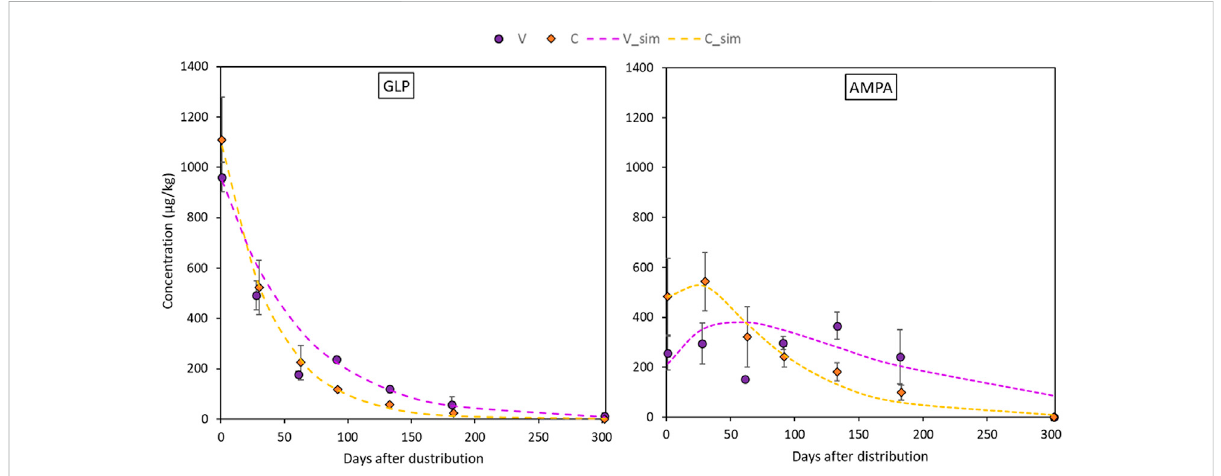
FIGURE 4 Dissipation dynamics of GLP in the topsoil layer (0 – 5 cm) for the the two sites fi tted with the SFO equation (on the left, Eq. 2) and formation/ dissipation dynamics of AMPA in the topsoil layer for the two sites fi tted in Eq. 3 (on the right). Dots refer to experimental concentrations (orange for Conegliano and purple for Valdobbiadene) and lines refer to fi tted dynamics.